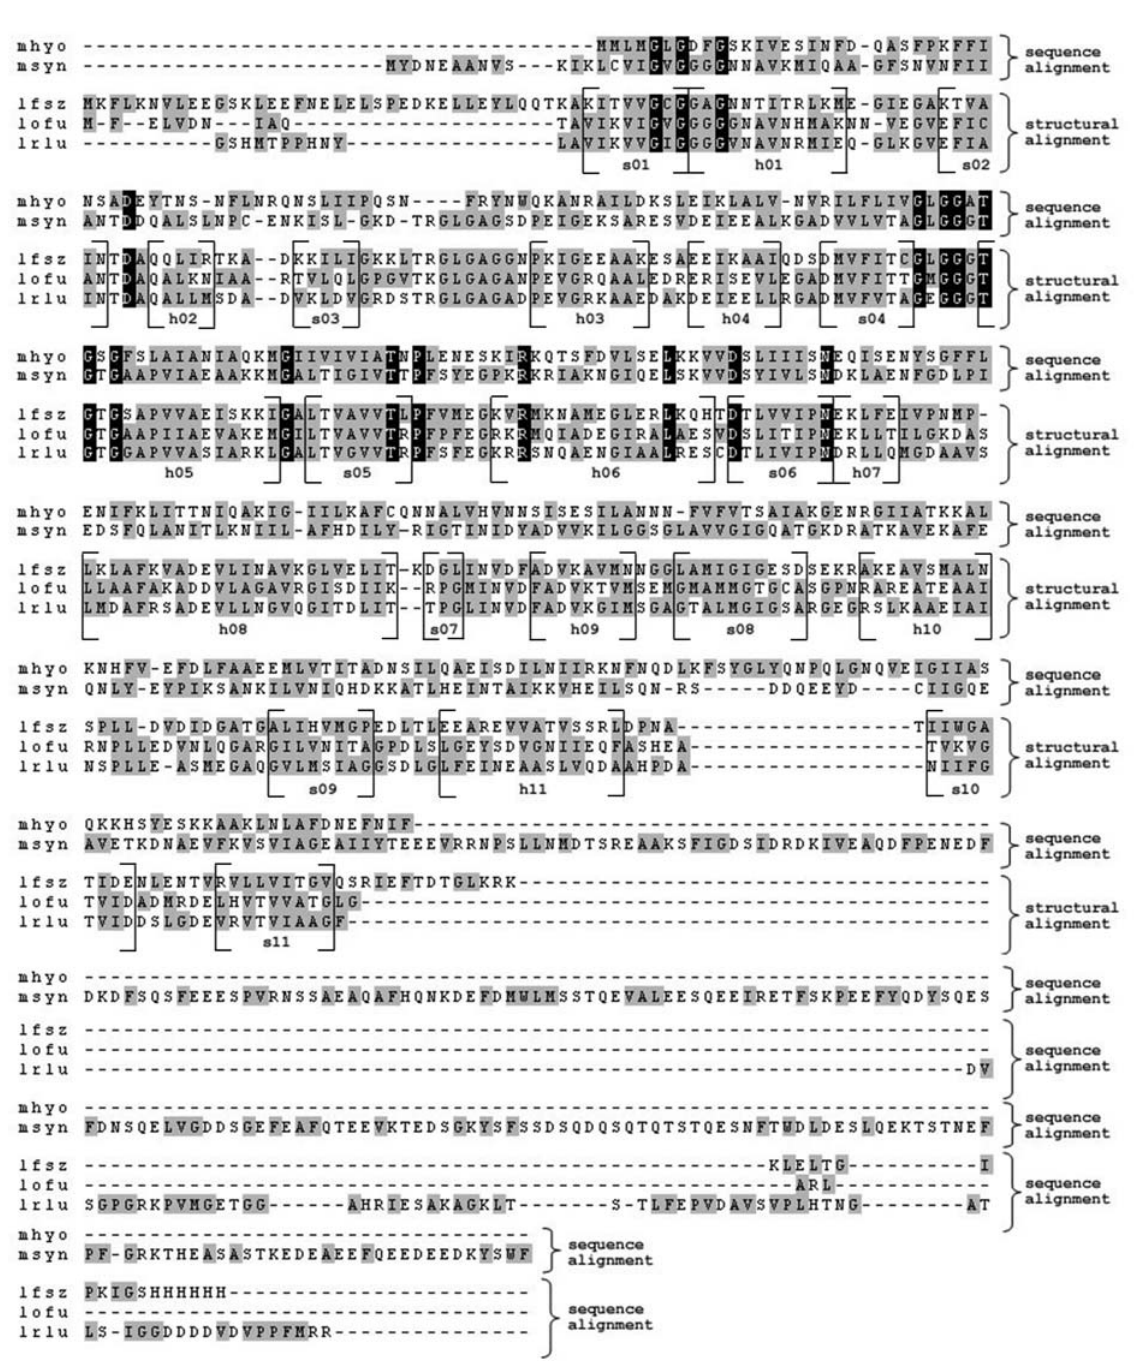
Figure 3 - Structural alignment of FtsZ proteins. FtsZ templates (pdb codes) 1fsz: M. jannaschii ; 1ofu: P. aeruginosa ; 1rlu: M. tuberculosis ) used to con- struct structural models of FtsZ proteins for M. synoviae (msyn) and M. hyopneumoniae 7448 (mhyo). Helices (h) and strands (s) in the template struc- tures are represented along their amino acid sequences. The sequence alignment of mycoplasma amino acid sequences is represented above the template structural